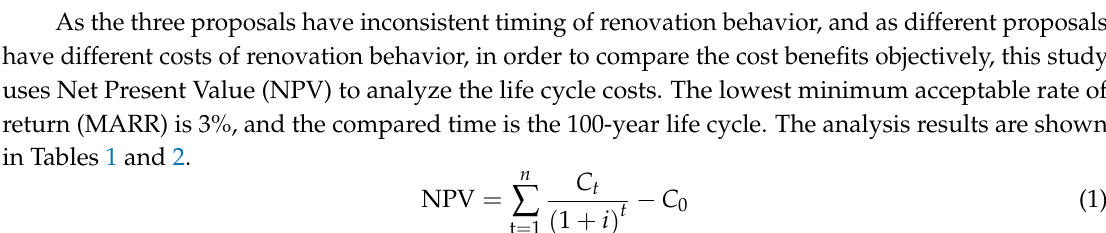
Figure 7. Cost analysis of BIM.